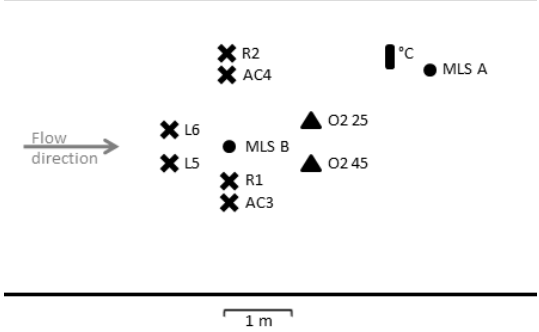
Figure 2. Overview of the instrumental setup at the Holtemme for the testing phase in June 2015. R1, R2, resin-only HPFM; AC3, AC4, activated-carbon-only HPFM; L5, L6, alternating lay- ered HPFMs; MLSA, MLSB, multi-level sampler; O2 25, O2 45, subsurface oxygen logger; ◦ C, vertical temperature